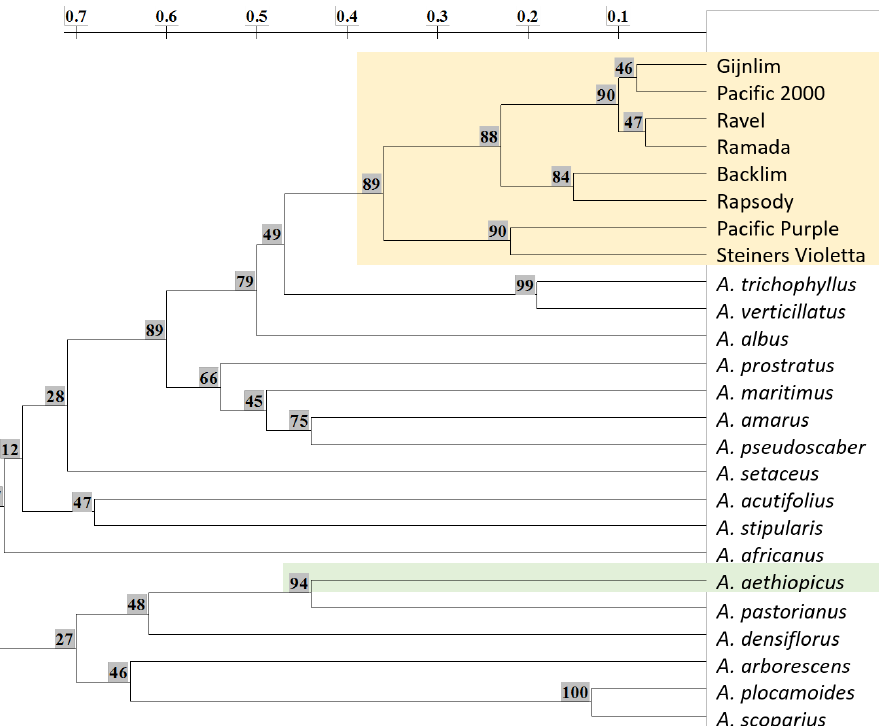
Figure 7. Determination of the phylogenetic distance between A. aethiopicus (green) and A. officinalis (cultivars; yellow) using 222 bands from SSR analysis. Numbers at the branches indicate bootstrap values in percent.